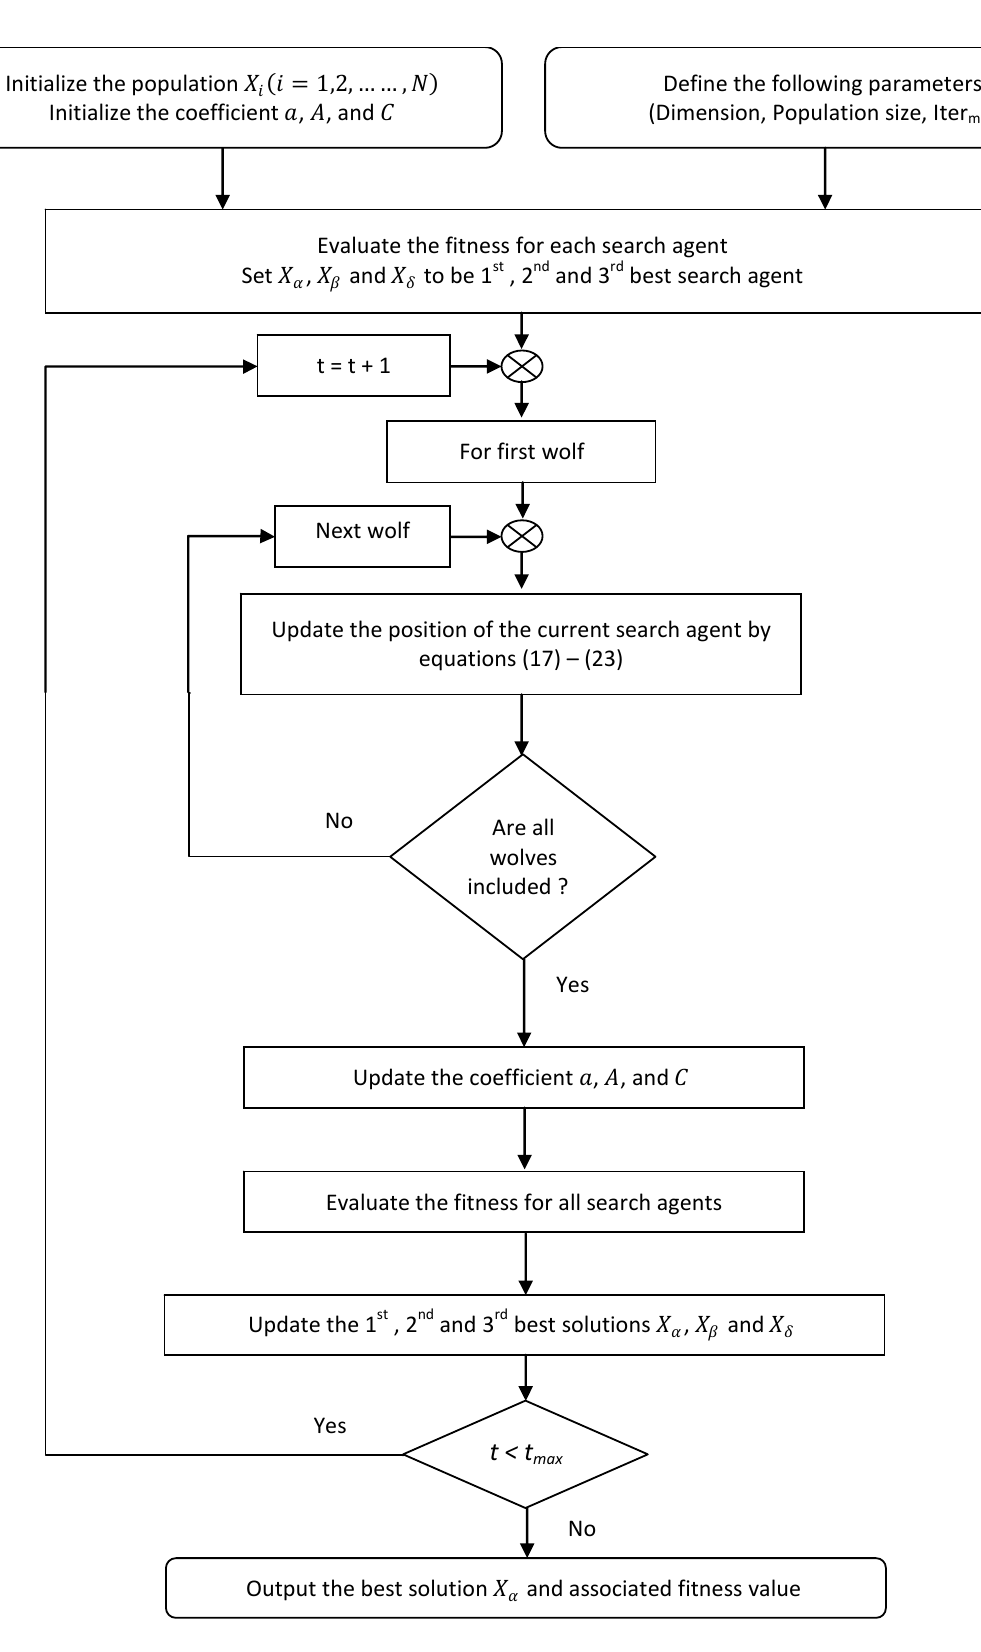
Figure 4. The flow chart of the GWO algorithm.